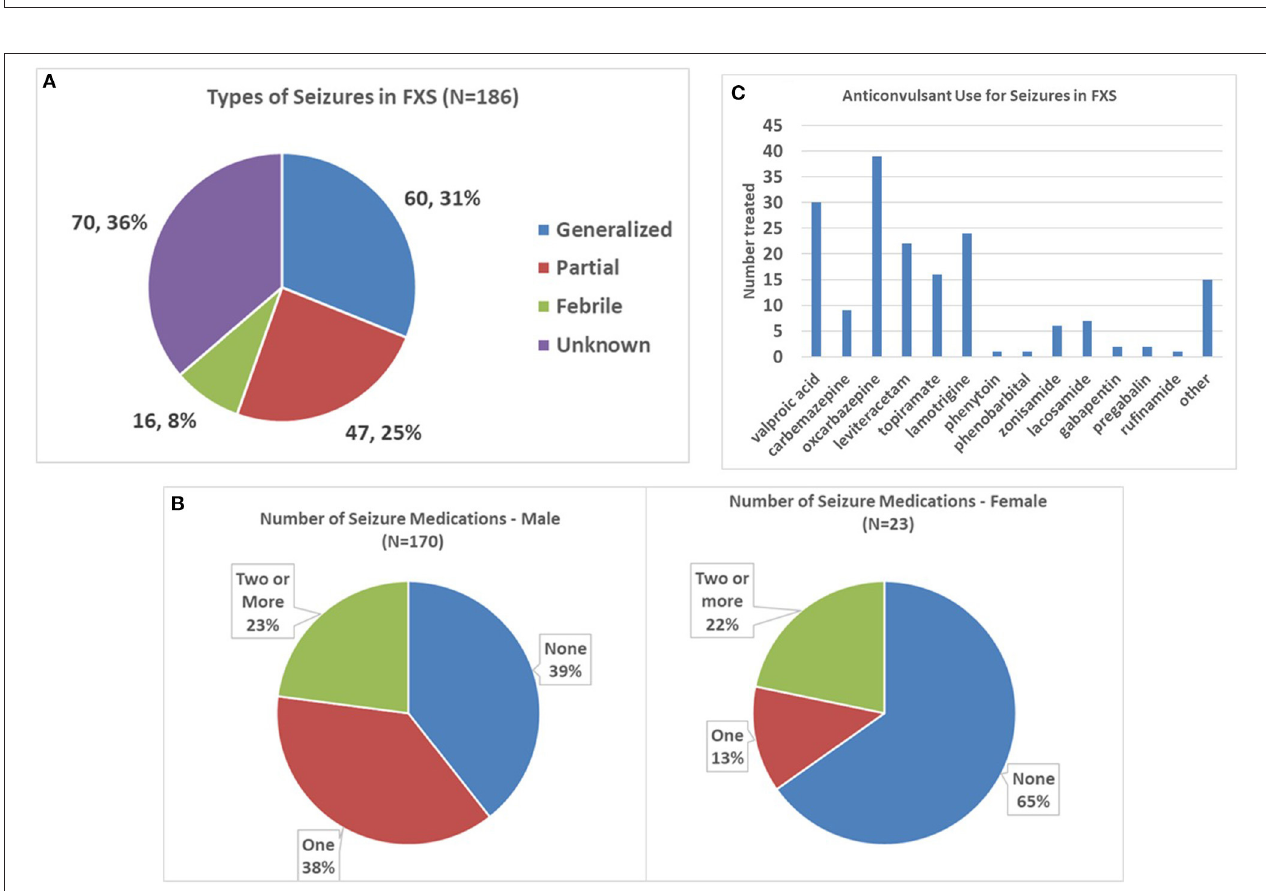
FIGURE 3 | Seizure types and anticonvulsant use in FXS. (A) Pie graph depicting the proportion of each seizure type in the entire FXS cohort. (B) Graphs showing the number of anticonvulsants per patient in males and females, respectively. Note the higher proportion of males on anticonvulsants. (C) Number of patients with FXS using the most common anticonvulsants. Oxcarbazepine, valproic acid, and lamotrigine were the three most commonly prescribed anticonvulsants.